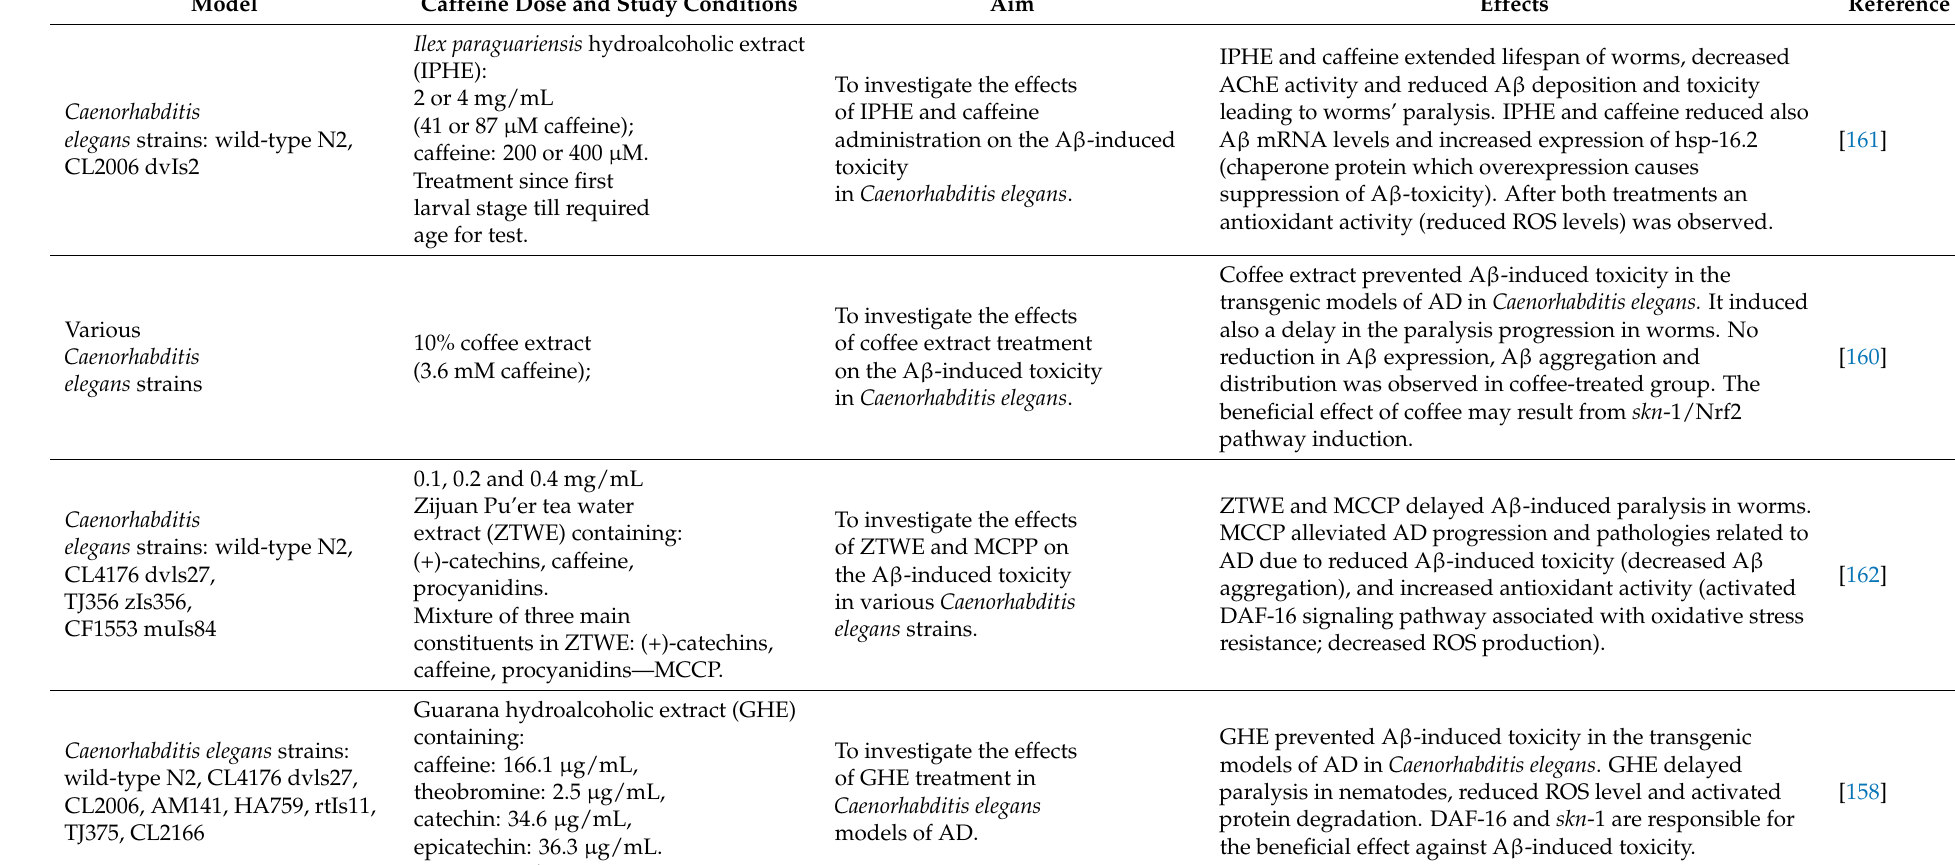
Table 4. Nematode